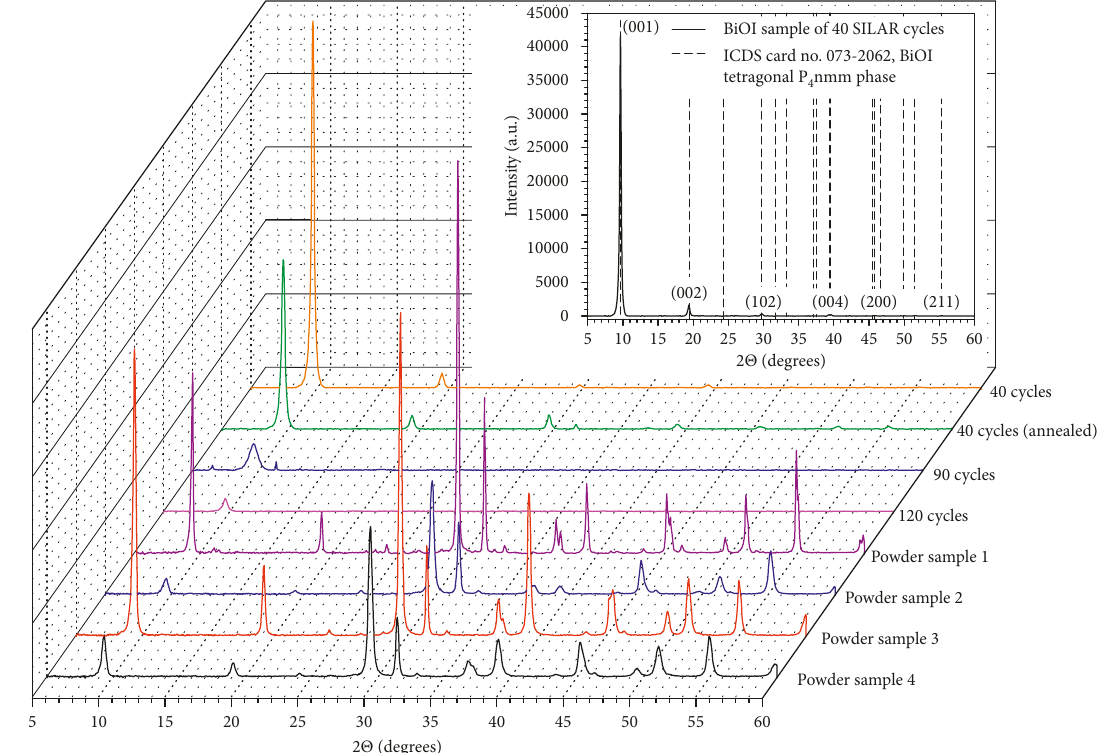
Figure 4: X-ray diffraction patterns corresponding to BiOI samples grown on ZnO thin films and BiOI powder samples.